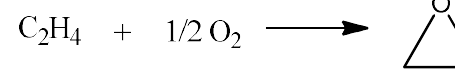
Figure 2. Synthesis of ethylene oxide.